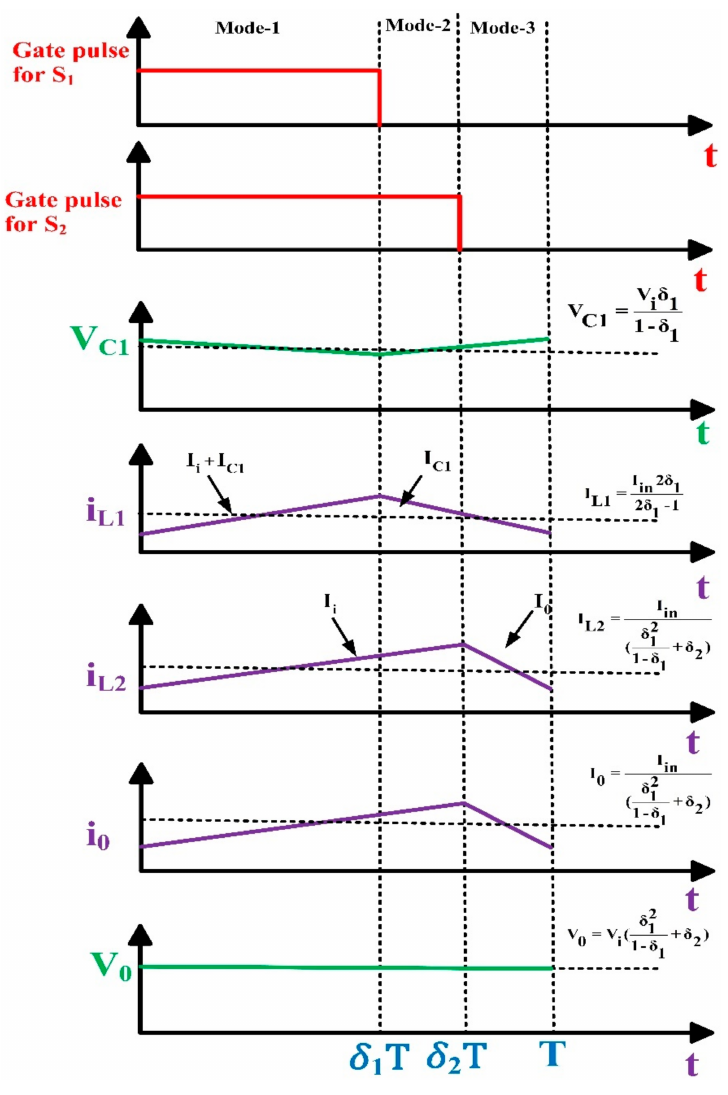
Figure 2. The proposed converter’s waveforms for one switching